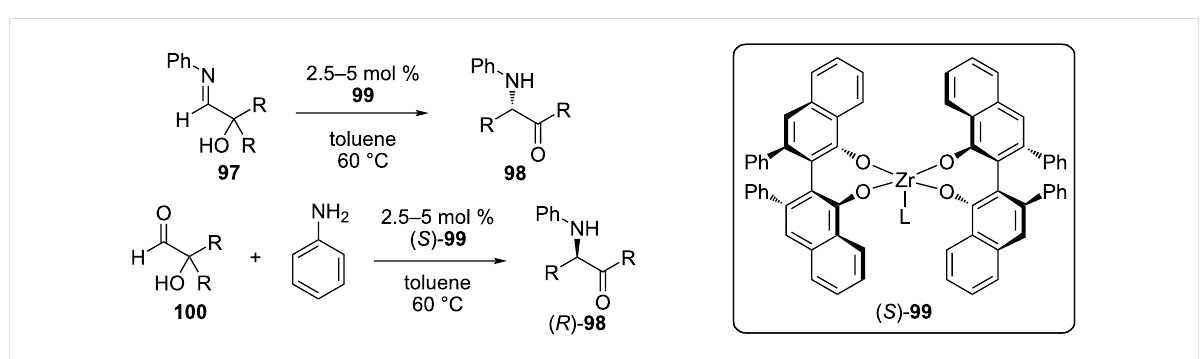
Figure 18: α -Iminol rearrangements catalyzed by VANOL Zr ( 99 ). The rearrangement can be conducted with preformed iminol 97 or from a mixture of aldehyde 100 and aniline.